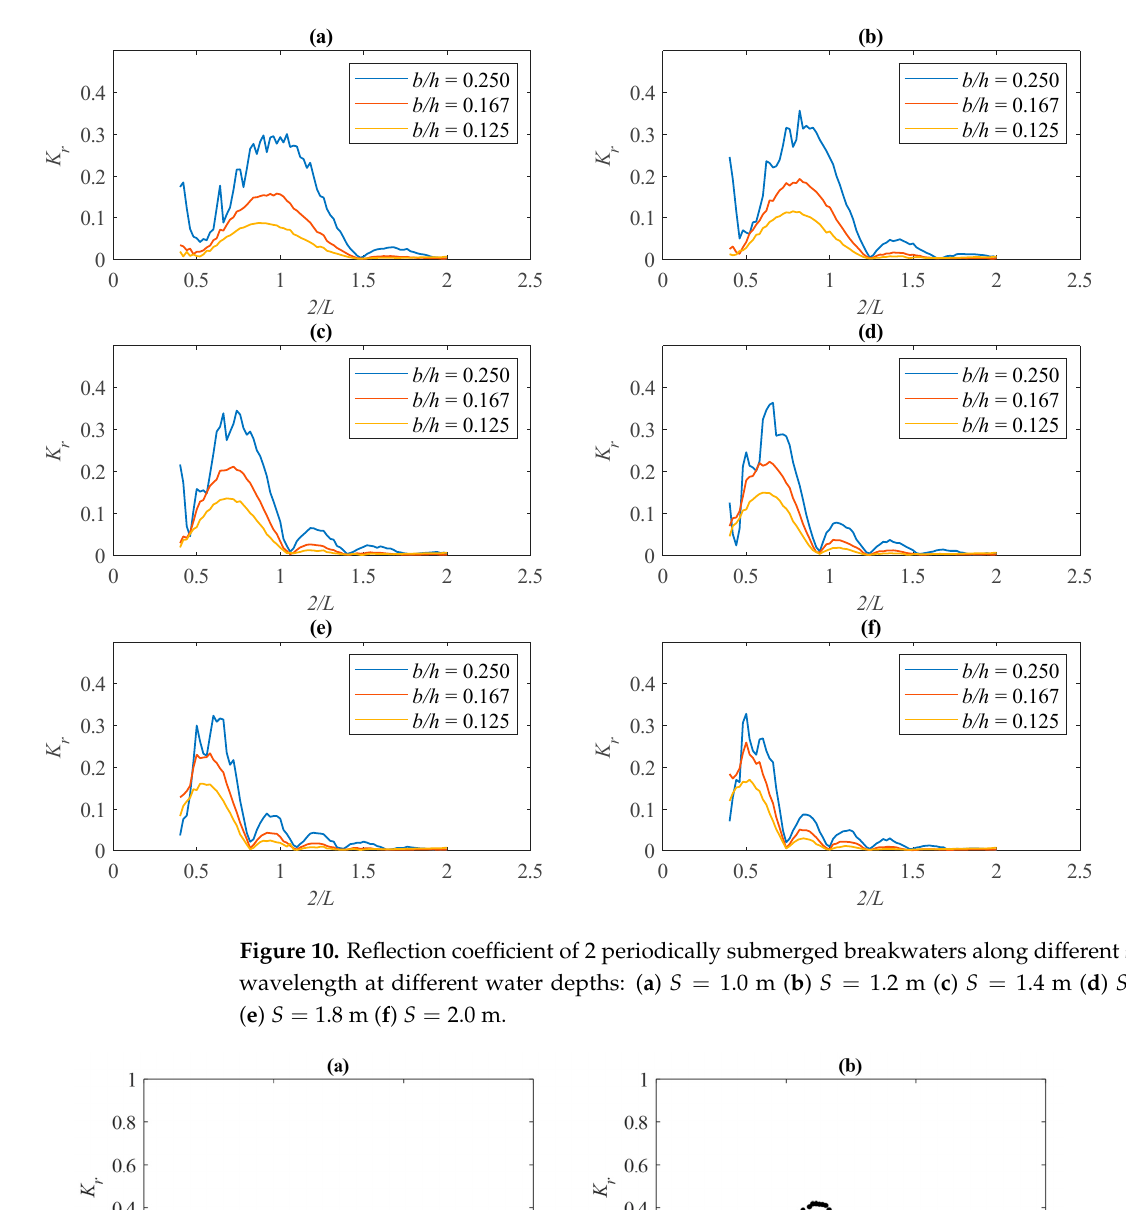
Figure 10. Reflection coefficient of 2 periodically submerged breakwaters along different structural wavelength at different water depths: ( a ) S = 1.0 m ( b ) S = 1.2 m ( c ) S = 1.4 m ( d ) S = 1.6 m ( e ) S = 1.8 m ( f ) S = 2.0 m.